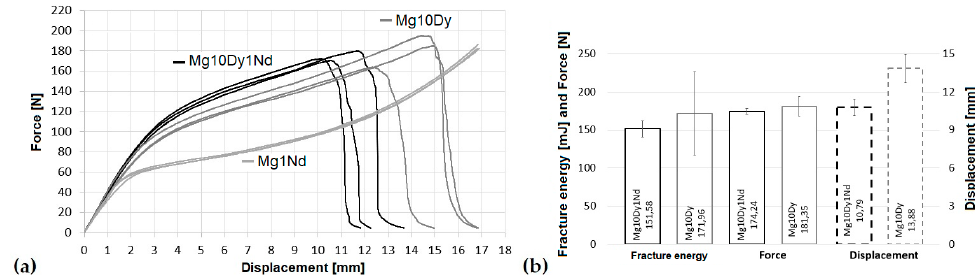
Figure 7. Force–displacement curves of C-rings tests under compressive loading in Ringer solution up to fracture for the Mg10Dy1Nd, Mg10Dy and Mg1Nd alloys ( a ) and their properties ( b